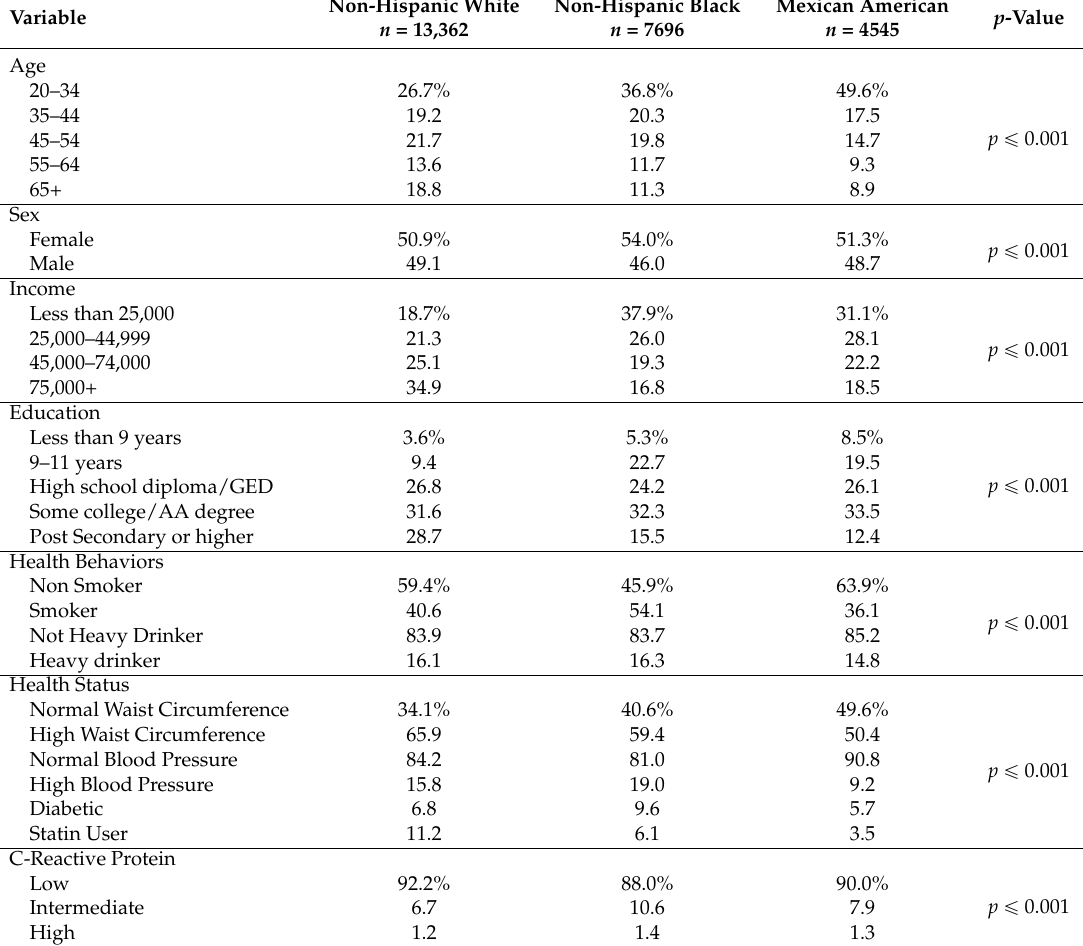
Table 1. Weighted sample descriptive statistics by race/ethnicity, national health and nutrition examination survey, United States,